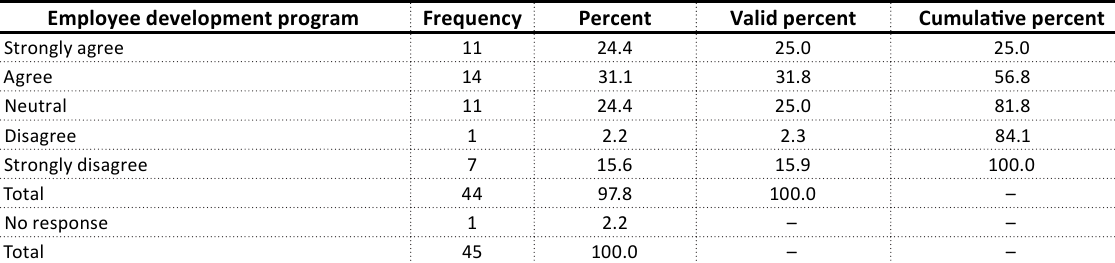
Table 7. Frequency showing the employee development